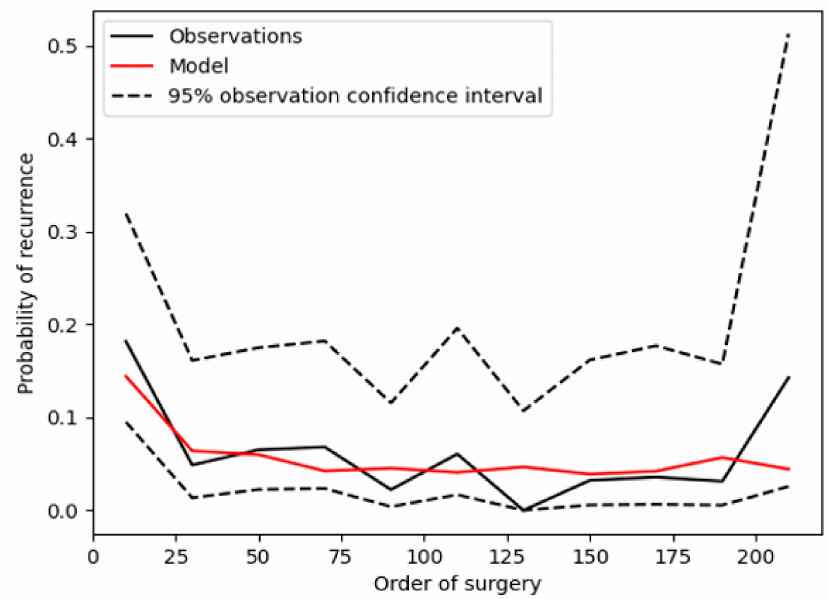
Figure A2. Analysis performed on the three hospitals with the earliest implementation and > 100